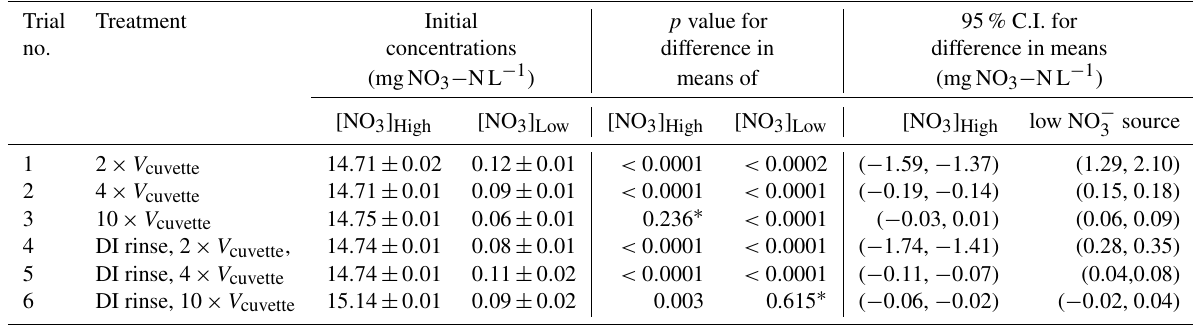
Table 1. Results of testing cross-contamination of cuvette. Treatment indicates the volume of sample pumped from the current source for cuvette rinsing relative to cuvette volume ( V cuvette ) , and whether or not a prior DI rinse was used. C.I. denotes the confidence interval. Trial Treatment Initial p value for 95% C.I. for no. concentrations difference in